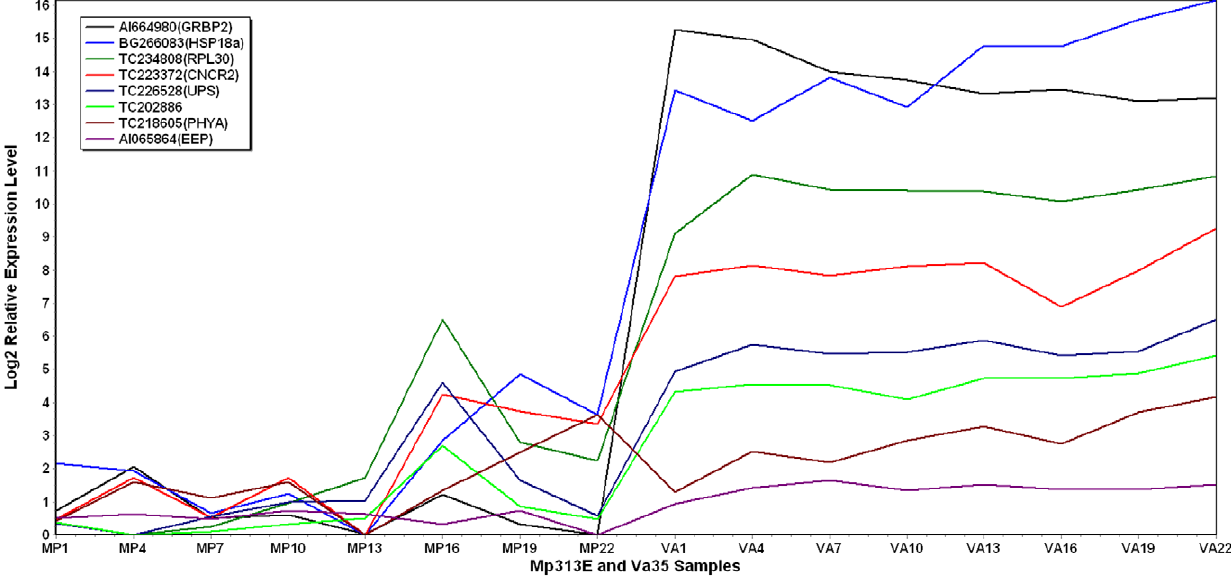
Figure 6. 2D plot showing gene expression levels over a period of 21 days after the fungal inoculation. These genes are highly expressed in Va35 than in